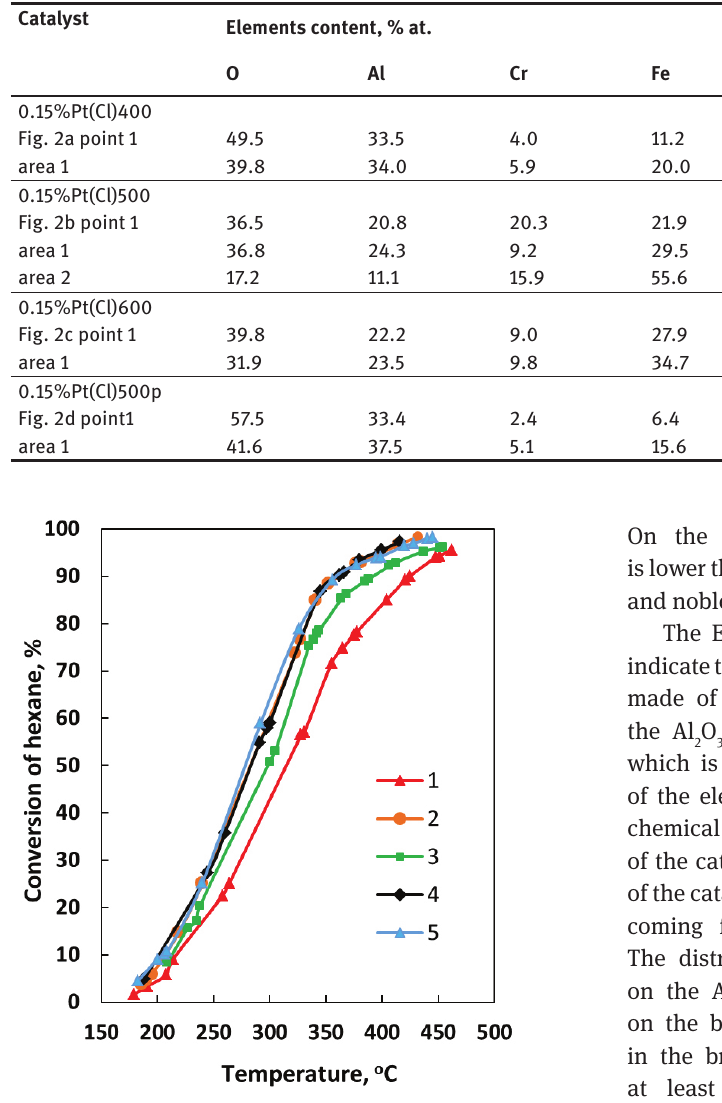
Figure 1: Effect of monolithic 0.15% wt. Pt catalyst calcination conditions on hexane conversion. Calcination conditions: 1 – 3 h